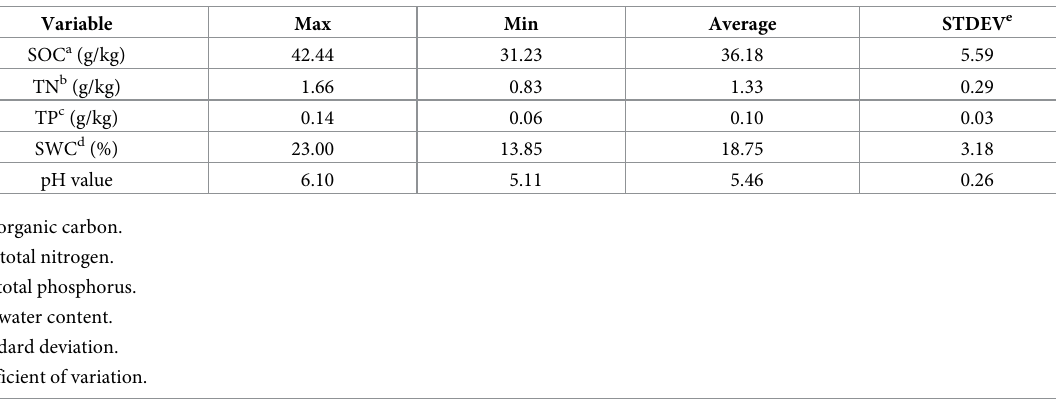
Table 2. Descriptive statistics of the soil properties in the tropical rainforest of Jianfengling National Nature